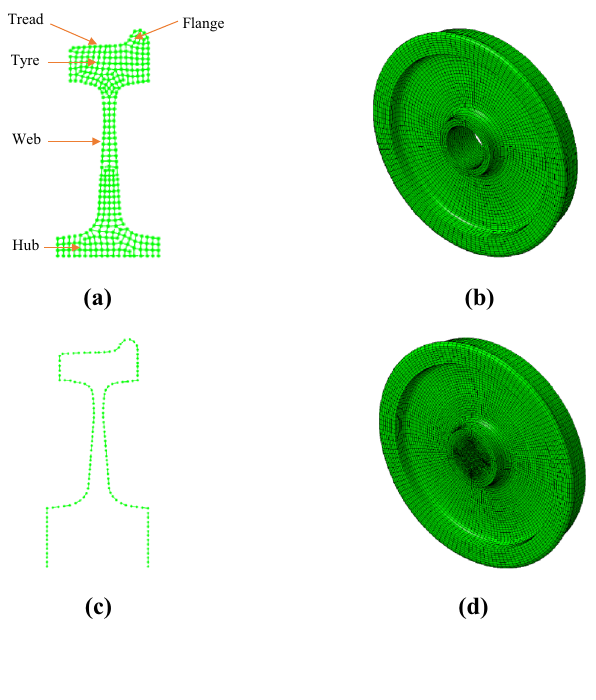
Fig. 4 Finite element and boundary element meshes of the wheel. a 2.5D FEM mesh (MATLAB), b 3D FEM mesh (ANSYS), c 2.5D BEM mesh (MATLAB) and d 3D BEM mesh (LMS